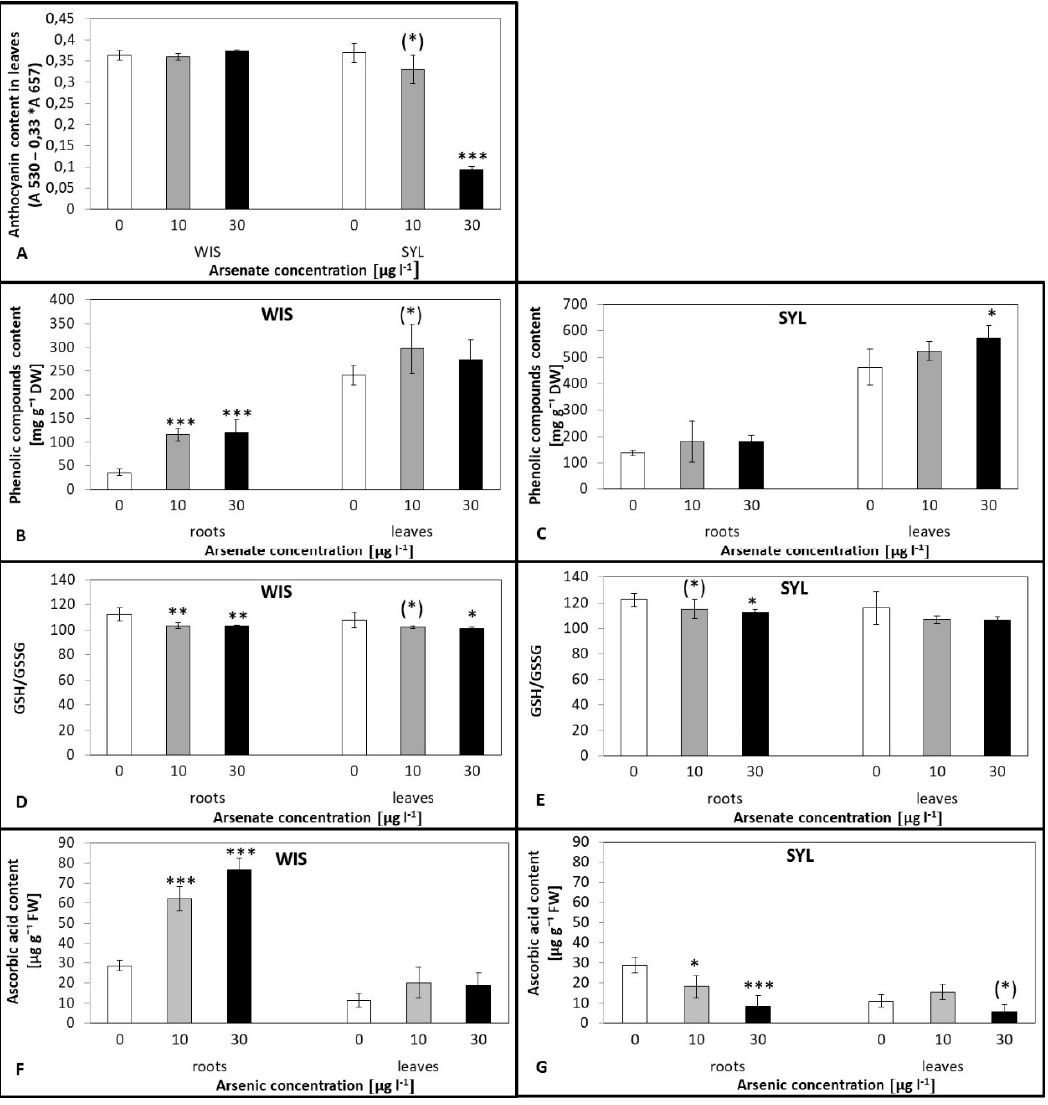
Figure 5. Effect of arsenic on anthocyanin ( A ) and phenolics contents ( B,C ), GSH/GSSG - glutathione Figure 5. E ff ect of arsenic on anthocyanin ( A ) and phenolics contents ( B , C ), GSH / GSSG - glutathione forms ratio ( D,E ), and ascorbate contents ( F, G ) in two contrasting tobacco genotypes (A,B,D, and F forms ratio ( D , E ), and ascorbate contents ( F , G ) in two contrasting tobacco genotypes (( A , B , D , F ) tolerant tolerant N.tabacum cv.Wisconsin; A,C,E,G sensitive N. sylvestris ). 0, 10, and 30 µg l -1 arsenate N.tabacum cv.Wisconsin; ( A , C , E , G ) sensitive N. sylvestris ). 0, 10, and 30 µ g l − 1 arsenate treatments. treatments. Bars indicate standard deviations. Stars mean statistically significant differences from Bars indicate standard deviations. Stars mean statistically significant di ff erences from control at the control at the level α = 0.1 ((*)), 0.05(*), 0.01 (**) or 0.001(***), n = 4–5. level α = 0.1 ((*)), 0.05(*), 0.01 (**) or 0.001(***), n =